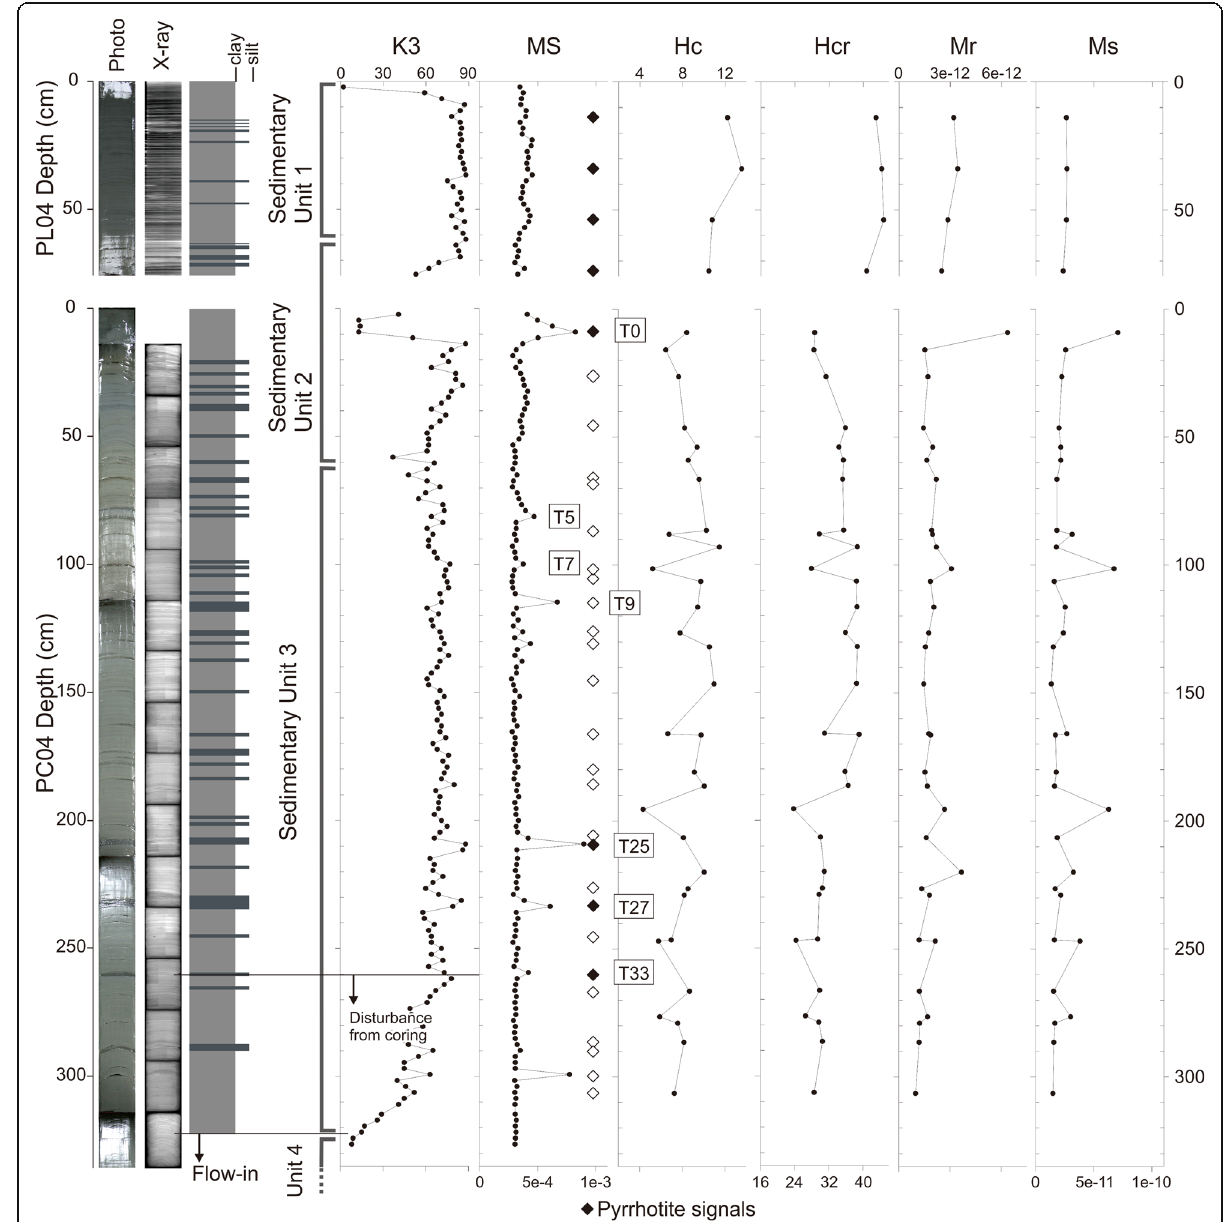
Fig. 4 Magnetic hysteresis parameters (Hc, Hcr, Mr, and Ms) from vibrating sample magnetometry (VSM), and magnetic susceptibility (MS) and K3 inclination (K3) measured using a KLY-4 magnetic susceptibility meter. Solid diamonds in the MS column indicate the presence of both pyrrhotite (transition at 34 K) and magnetite (119 K) as determined from SQUID-VSM (see Fig. 5a, b); open diamonds indicate magnetite only (see Fig. 5c, d). Peaks in the MS profile that correlate with identified turbidites are labeled. Increasing disturbance of PC04 by coring is noticeable below 262 cm